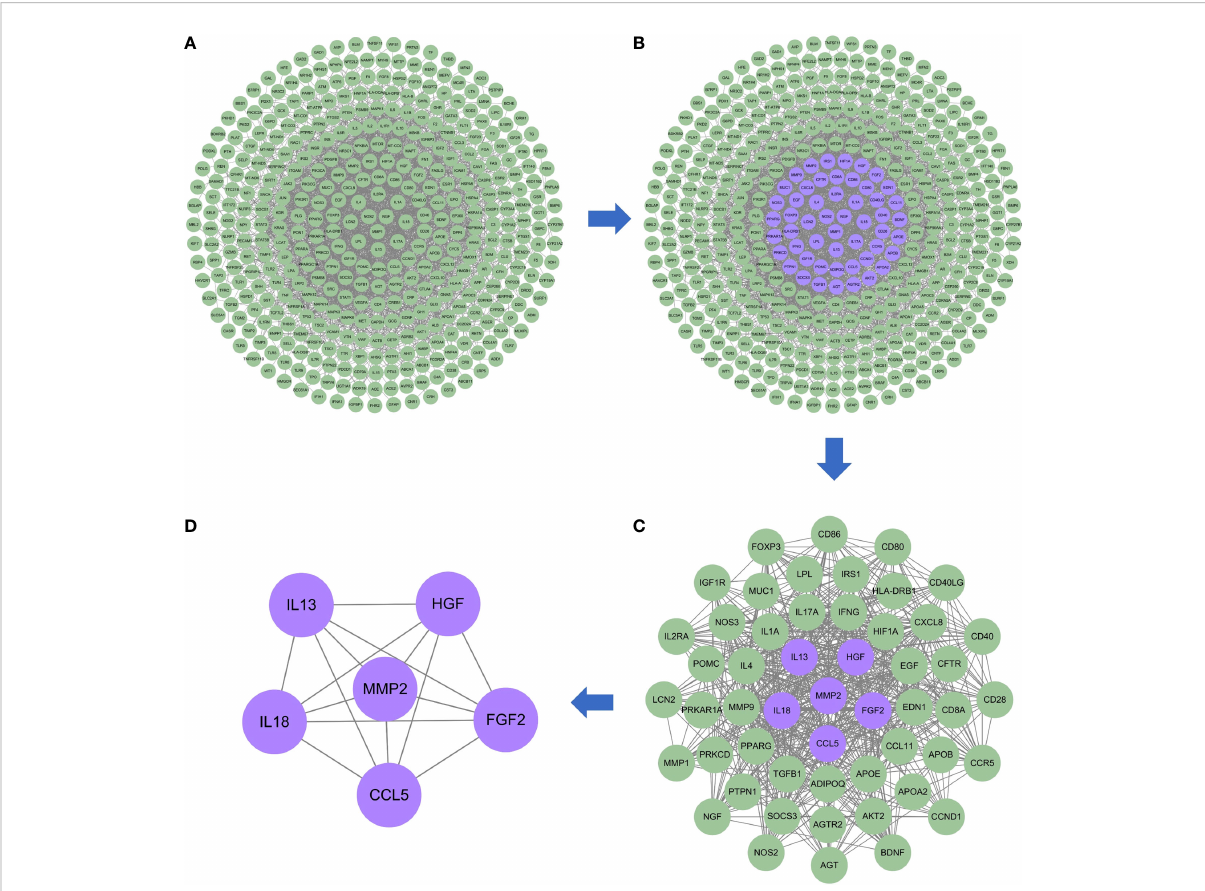
FIGURE 3 Protein – protein interaction network of the possible risk genes of DKD complicated with IBD. (A) The original PPI network of therapeutic targets and all nodes in the network are green. (B) The core nodes in this network screened by their topological features are purple, and the other nodes are green. (C) The sub-network constructed from the core nodes of B, the core nodes in this network screened by their topological features are purple, and the other nodes are green. (D) The sub-network constructed from the core nodes of C, all nodes in the network are purple and represent the fi nal central therapeutic targets obtained through screening.